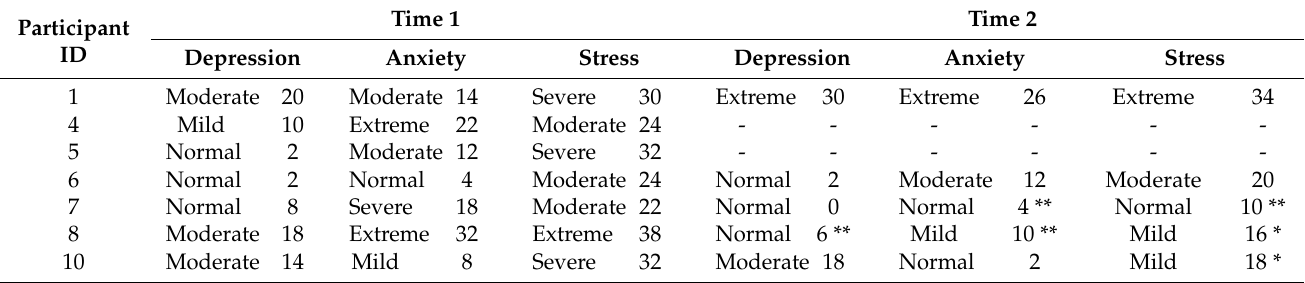
Table 4. DASS-21 measured depression, anxiety, and stress at pre- and